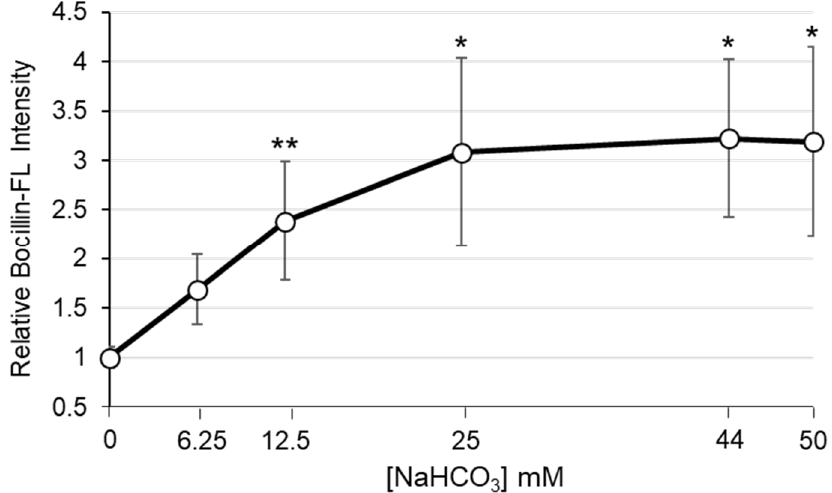
Figure 2. NaHCO 3 dose response impact on Bocillin-FL binding to purified PBP2a variant 246G; 50 µg/mL PBP2a was incubated with 50 µM Bocillin-FL and either 0, 6.25, 12.5, 25, 44, or 50 mM NaHCO 3 . Relative Bocillin intensity was normalized to a control lane consisting of 25 µM Bocillin-FL incubated with 50 µg/mL 246G PBP2a run on each gel. Final data was normalized to the intensity of 50 µg/mL PBP2a incubated with 50 µM Bocillin-FL and no NaHCO 3 (with this value set equal to 1.0). Asterisks represent significant differences in Bocillin-FL intensity at the indicated NaHCO 3 concentration as compared to no NaHCO 3 (Student’s t -test, * p < 0.05, ** p <